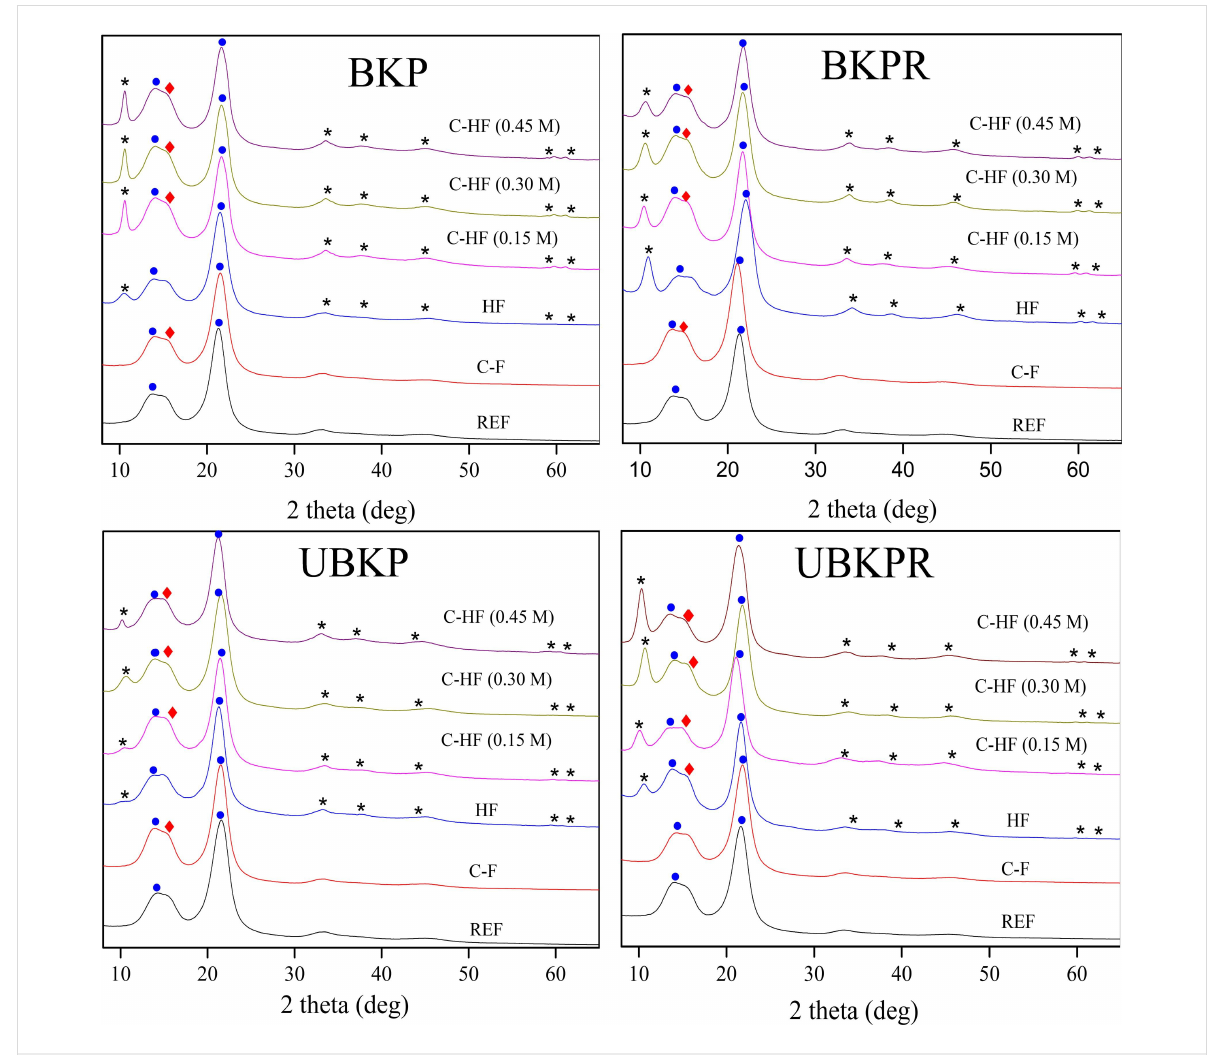
Figure 2: XRD spectra of pulp fibers (filled circles: fibers, asterisks: LDH, filled diamonds: abietic acid).